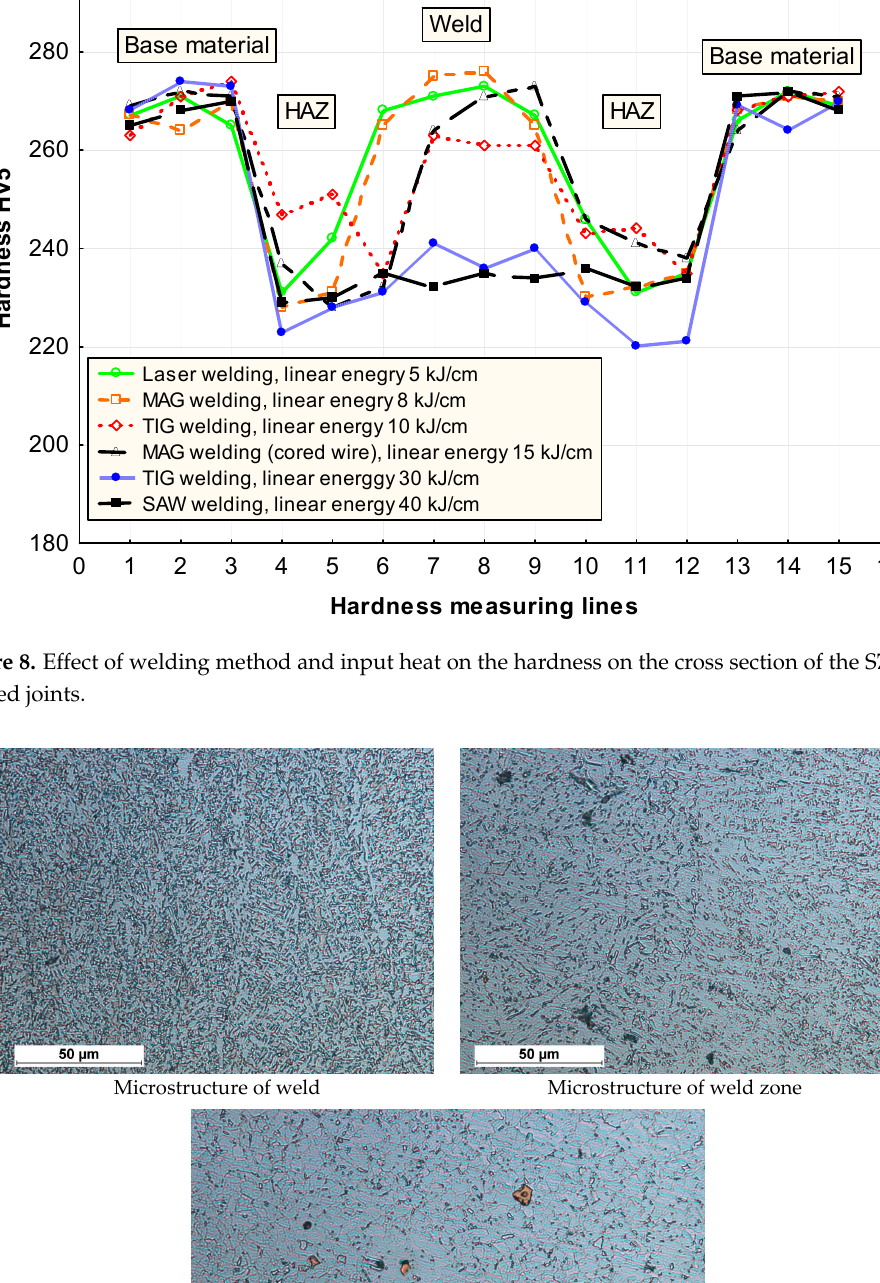
Figure 9. Microstructure of the MAG welded joint.